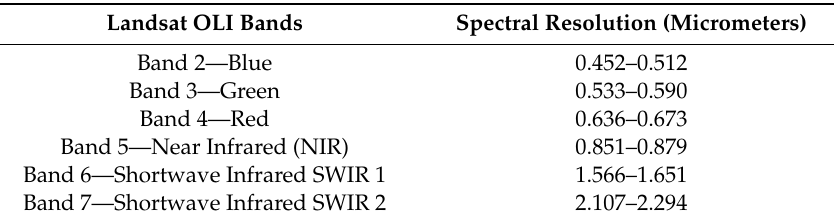
Table 1. Spectral resolution of the Landsat-8 OLI satellite bands used in the detection and monitoring of leaf-cutting ant nests in Tectona grandis